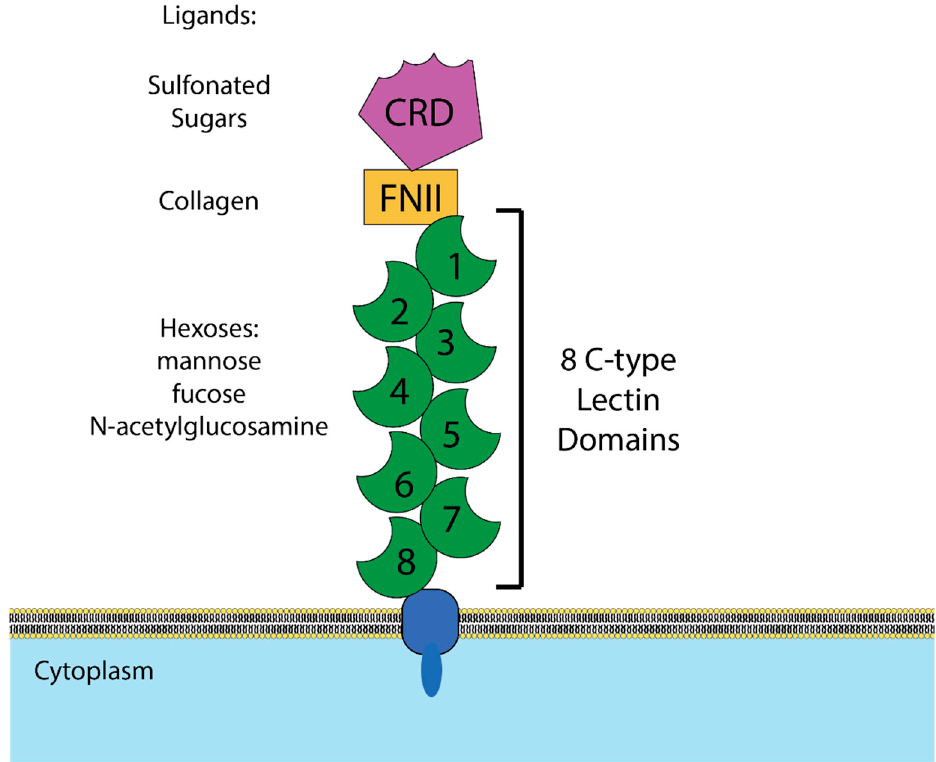
Figure 2. Structure of mannose receptor (MR). Graphical depiction of the domains of MR and the ligands bound by each domain. CRD = cysteine rich domain, which binds sulfonated sugars. FNII = fibronectin type II domain, which binds collagen. C-type lectin domains = calcium-dependent domains that have been demonstrated to bind mannose, fucose, and N-acetylglucosamine.